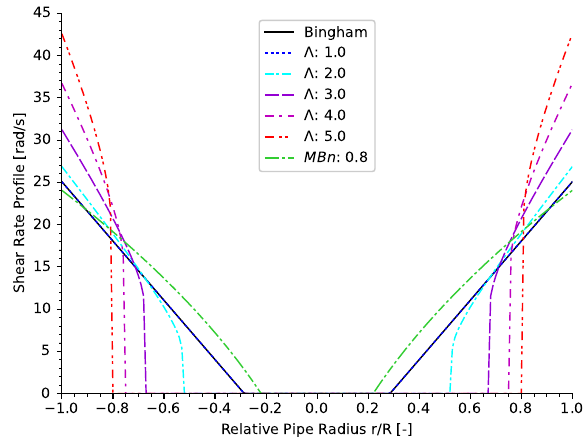
Figure 3: The shear rate profiles for a constant discharge Q of 2.5 L / s ( ̂︀ Q = 0.55 with R = 52.65 mm ) shows that thixotropy causes the shear to be non-linear and has a significant increasing effect on the plug zone, which is the region where the shear rate is zero.